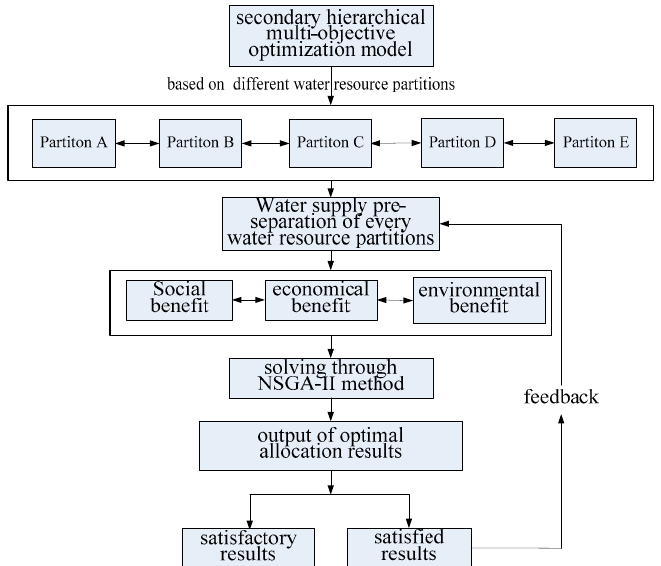
Figure 3. Model optimization and solution process (In the figure, Pastoral Energy Industry Partition,